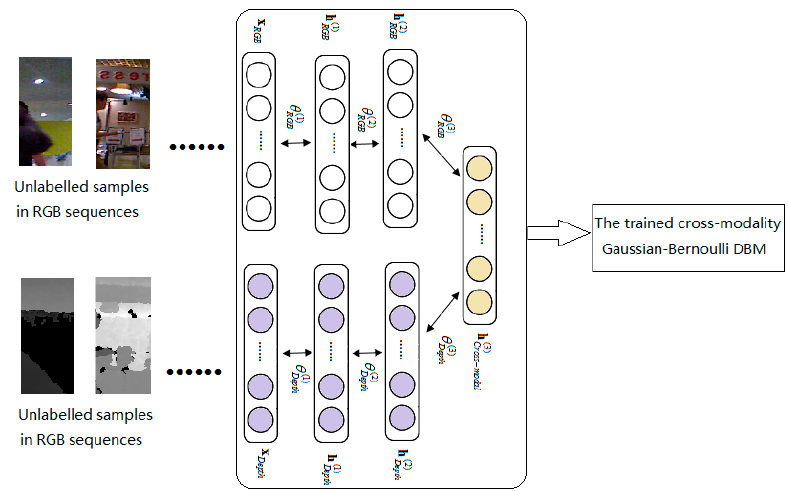
Figure 5. Offline learning of the proposed cross-modality Gaussian-Bernoulli DBM.